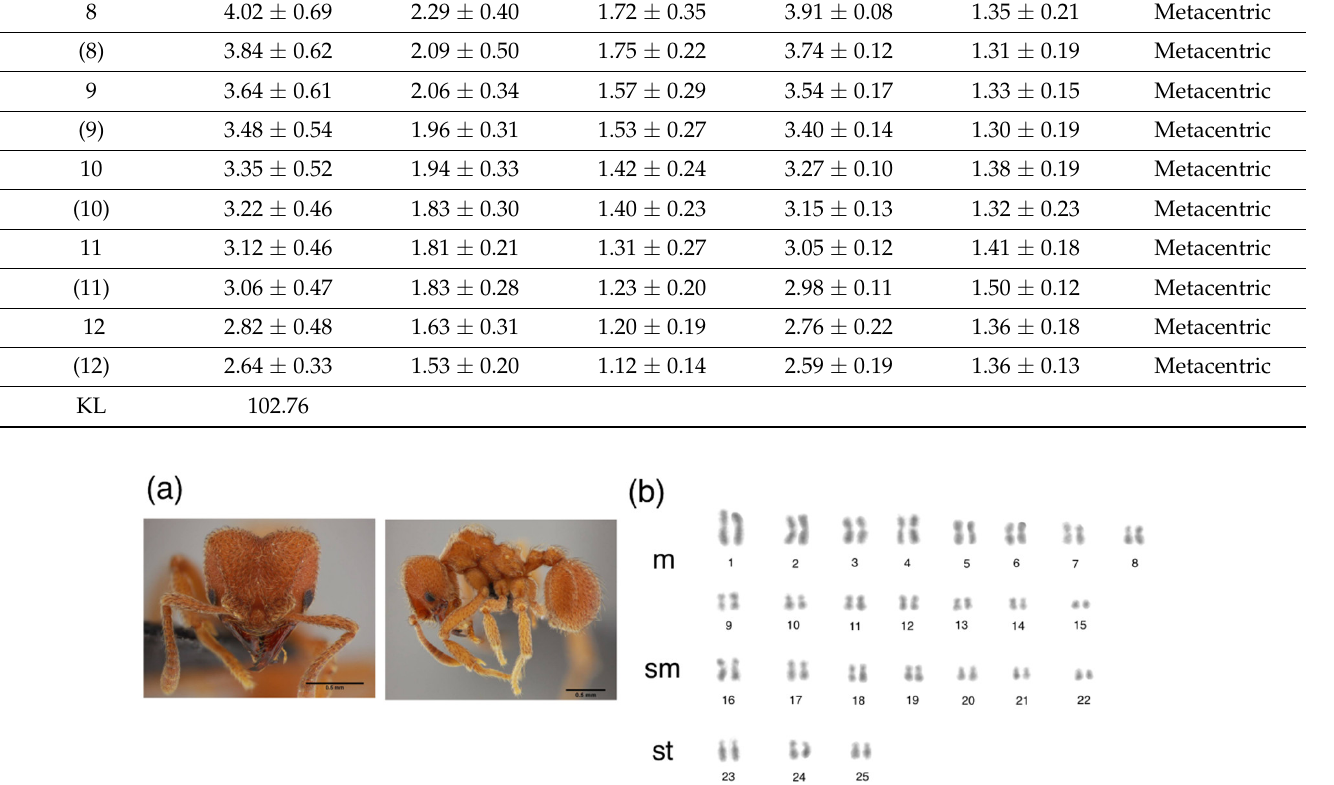
Species Studied